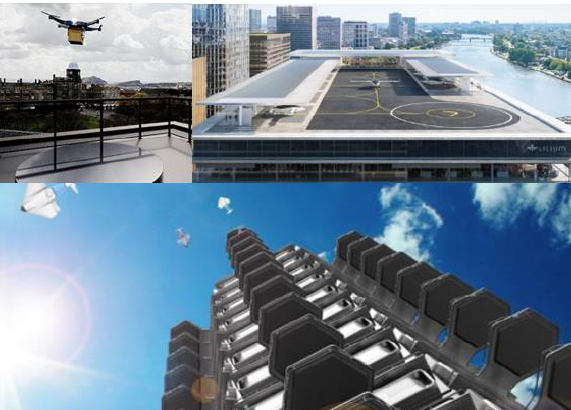
Figure 14. Design plans for Urban-Verti-Ports: a) (left) on a terrace for small-delivery drones, b) (left) on a roof for larger- passenger UAVs, and, c) (down) on the balcony extensions of a building for private/personal Figure 13. Adjusting building infrastructure to mobility needs through the centuries: From Stables and Docks to Car Parking and Verti-Ports.